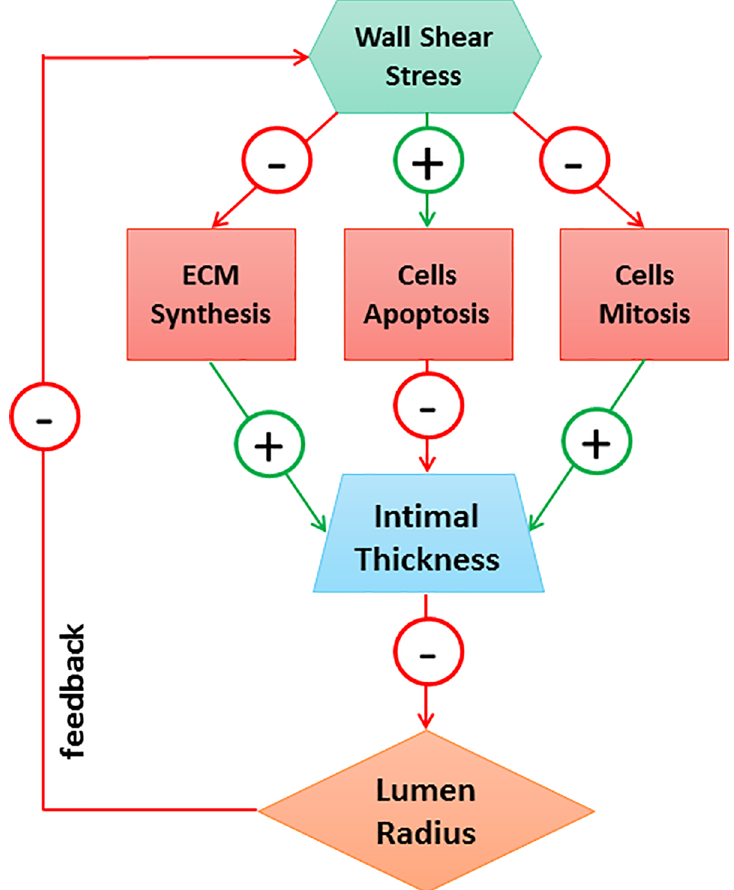
Fig 3. DynamicalSystem (DS). Conceptualscheme of the subset of DS that replicates hyperplasia during the first month of post-surgical follow-up[21].